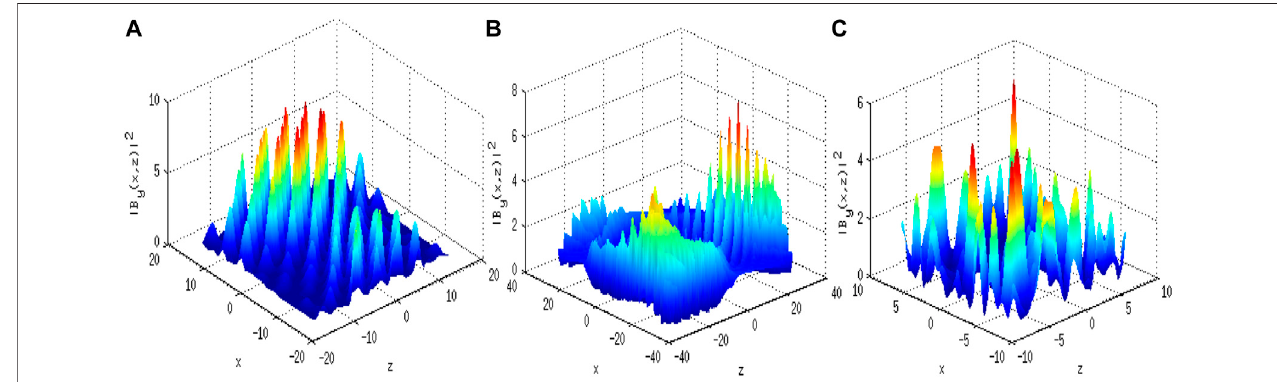
FIGURE6| Normalizedmagnetic fi eldintensityofwave | B 2 y | / B 2 n inanormalizedx – zplane( x normalizedwith x n (cid:2) ρ s and z normalizedby z n (cid:2) 2/ k 0 z withIC-1for (A) α , α (cid:2) 0 . 2, (B) α , α (cid:2) 0 . 1, and (C) α , α (cid:2) 0 . 4. “ Reproduced from [(Gaur and Sharma, 2015), J. Geophys. Res. Space Physics, 120, 2,397 – 2,408, doi:10.1002/ x z x z x z 2014JA020771], with the permission of AGU Publishing. ”